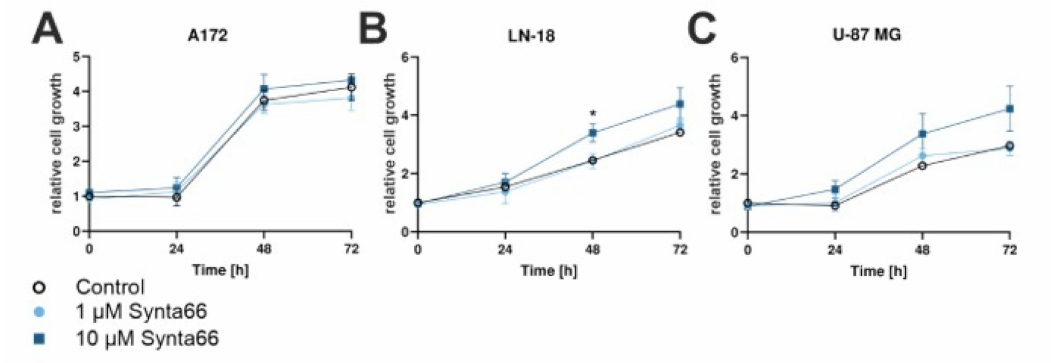
Figure 7. E ff ect of Synta66 on cell growth: ( A – C ) E ff ect of Synta66 (1 and 10 µ M, light and dark blue respectively) on proliferation of GBM cell lines ( A ) LN-18, ( B ) A172 and ( C ) U-87 MG was